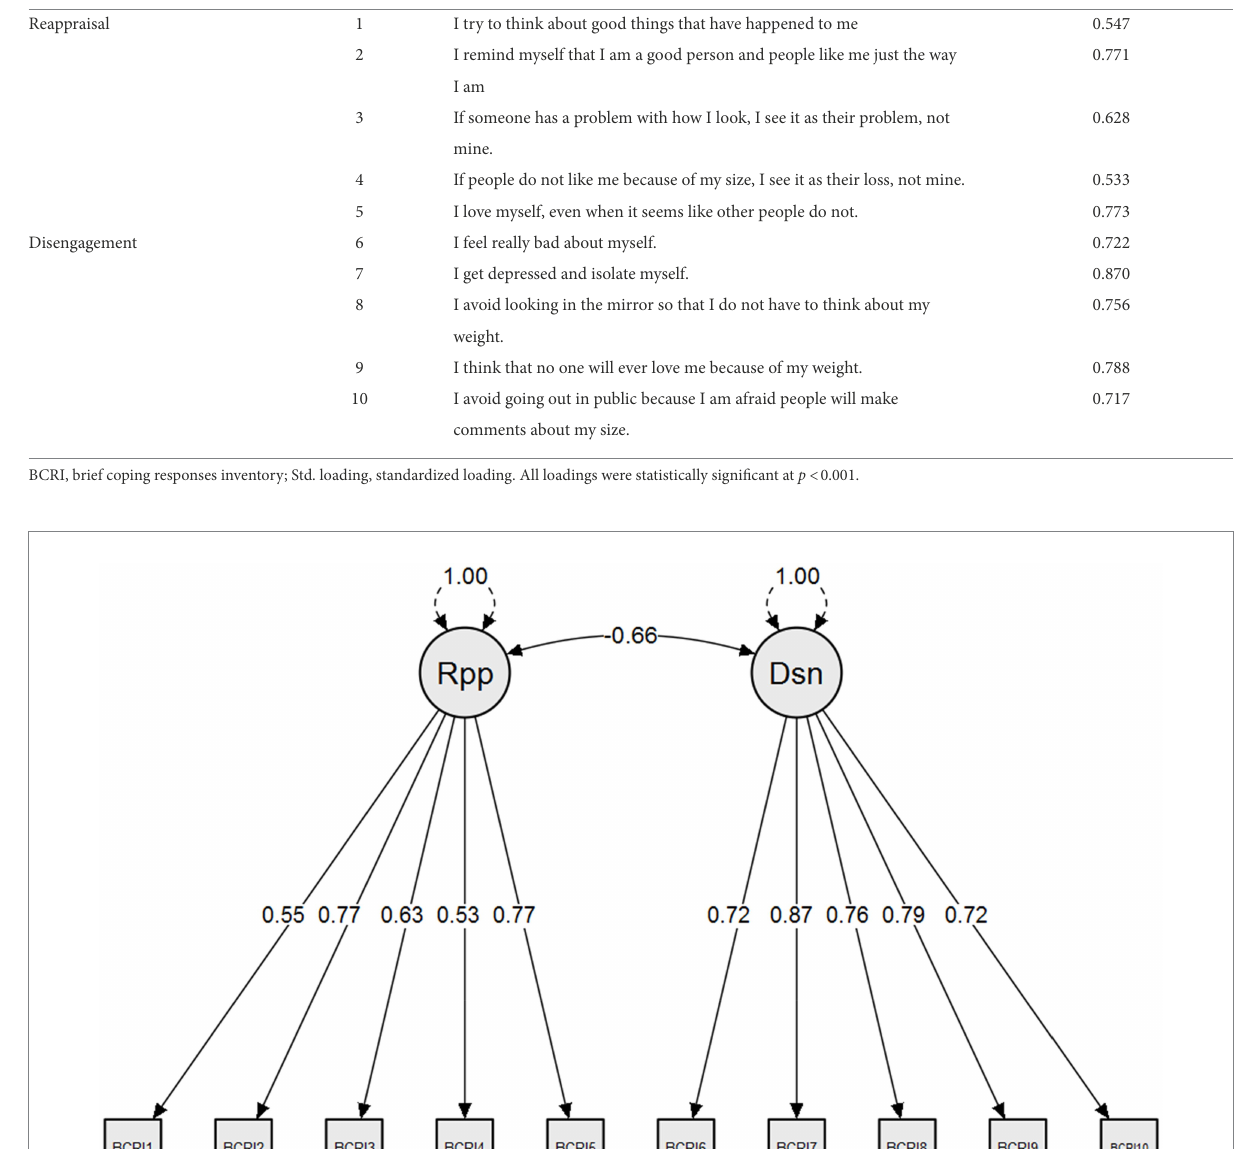
Table 2 Standardized item loadings for the two-factor model of the BCRI ( n = 253). Subscale Item Item content Std. loading